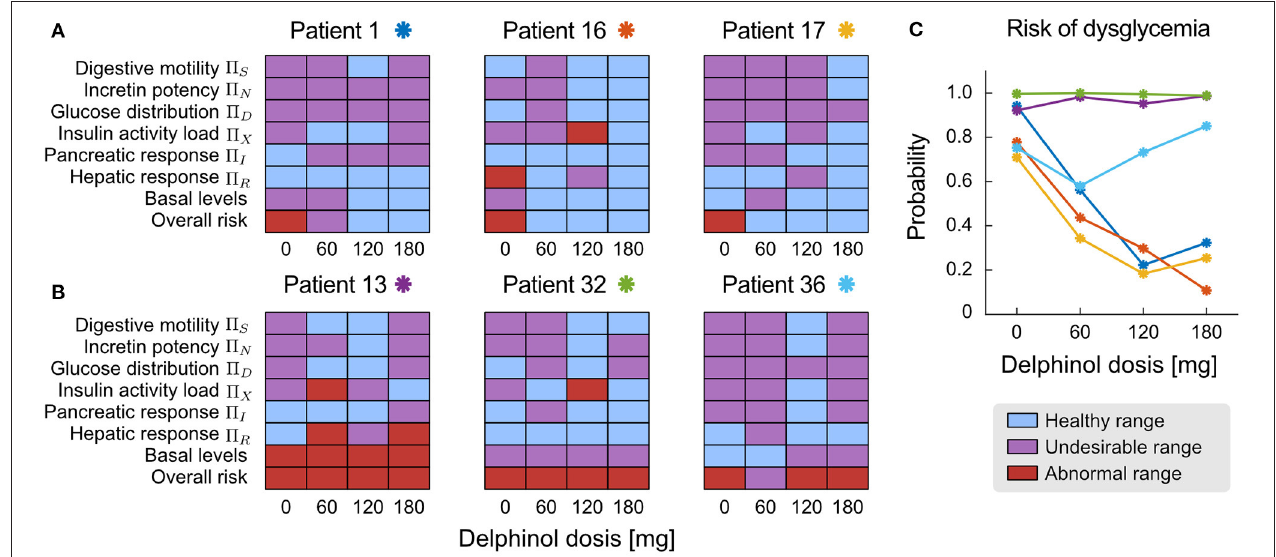
FIGURE 7 | Patient-wise assessment of the dose-dependent effects of pre-prandial Delphinol ® . In the general cohort, some individuals reacted more positively to Delphinol ® than others, decreasing their dysglycemia risk. This figure presents exemplary results for both types of patients. (A) Patients 1, 16, and 17 show a clear and dose-dependent improvement of their overall glycemic function expressed by the normalization of NDNs related to physiological subsystems involved in glycemic control. (B) Patients 13, 32, and 36 do not clearly respond to pre-prandial Delphinol ® treatment in the doses considered by this study, as assessed by the less pronounced effect on normalizing the NDNs of internal physiological subsystem. (C) Effect of pre-prandial Delphinol ® on the overall risk of dysglycemia, yielding consistent results for the same